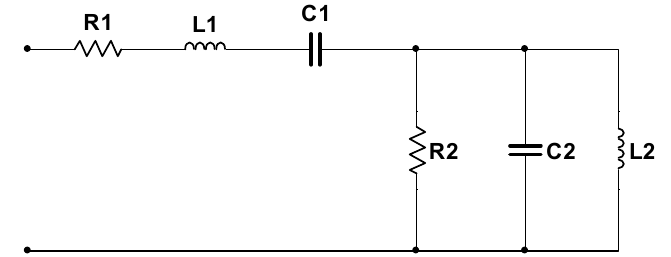
Figure 4. Circuit model at Ku-band. Table 2. Component values of the lumped-element circuit (Figure 3) for scaffold composites of Wangi rice starch and nHA at X-band.